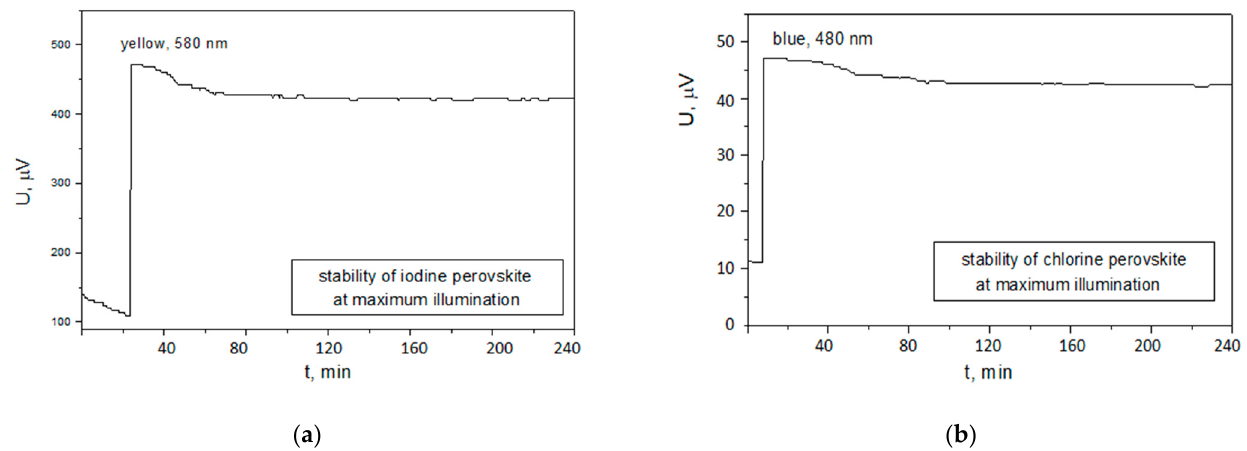
Figure 8. Stability of the photovoltage against time at room temperature and at a maximum illumination with the specific absorption wavelength: ( a ) for the iodine-based perovskite solar cell; ( b ) for the chlorine-based perovskite solar cell.